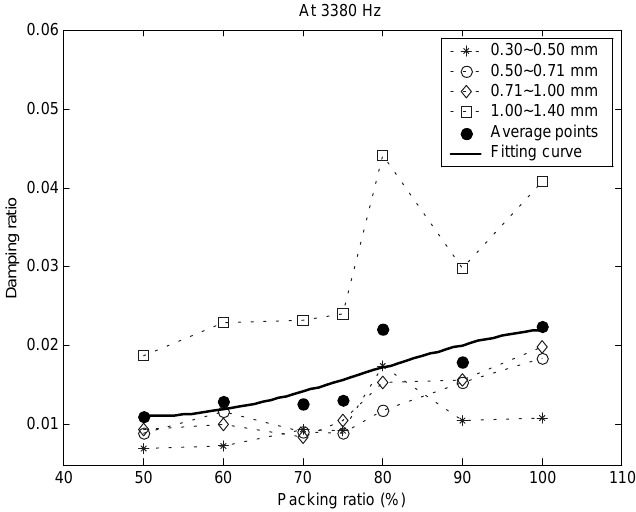
Fig. 7. Damping ratio vs. packing ratio for different particle diameters at 3380 Hz.